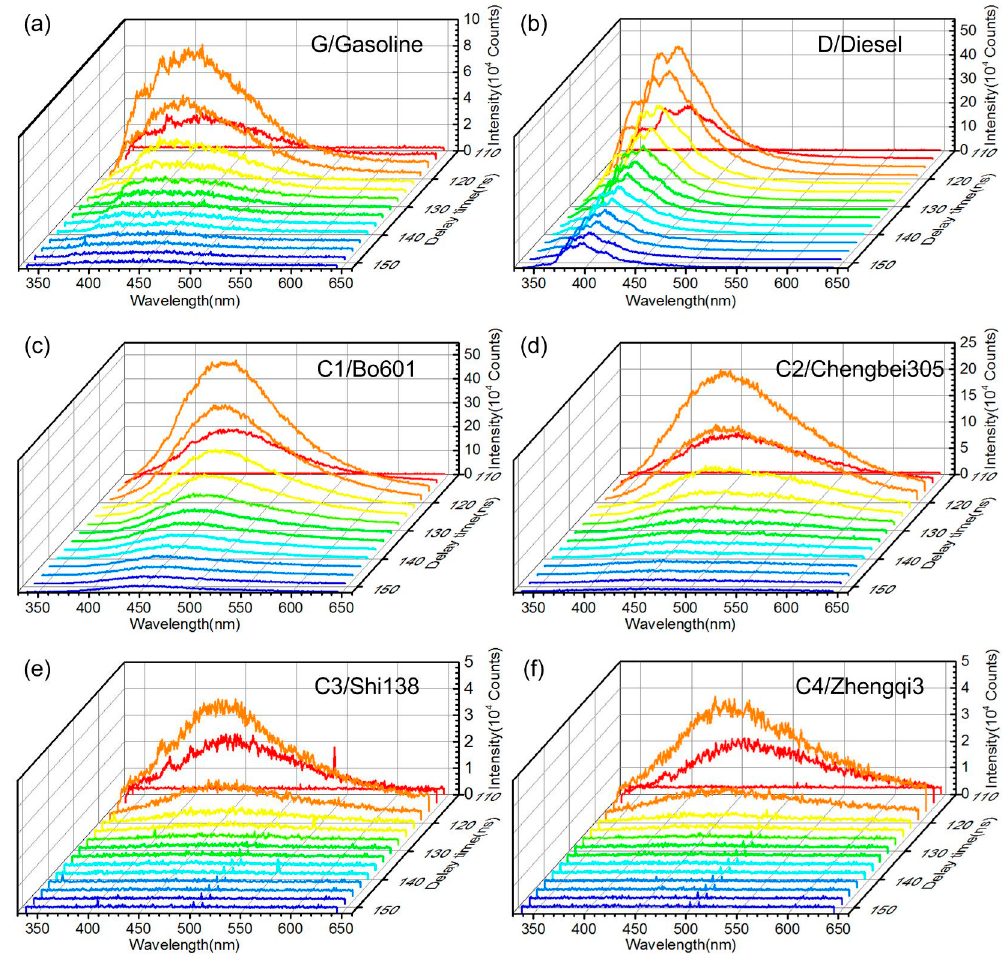
Figure 5. Typical time-resolved fluorescence spectra taken from gasoline (G), diesel (D) and 4 crude oil samples (C1–C4), ( a , b ) are the refined oil spectra of gasoline and diesel respectively, ( c – f ) are the crude oil spectra of B0601, Chengbei305, Shi138 and Zhengqi3 respectively. Table 2. The peak fluorescent intensity of six oil samples taken at five random detection positions. Detection